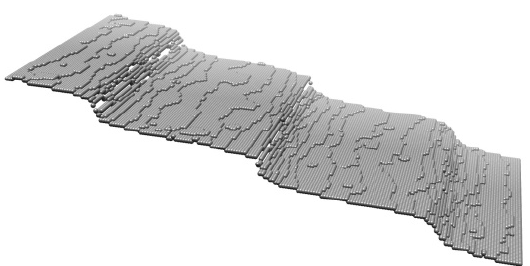
Figure 3. Bunches, c 0 = 0.02, P iES = 0, P dES = 1, p w = 1, l 0 = 10, n DS = 10. System size 300 × 100.